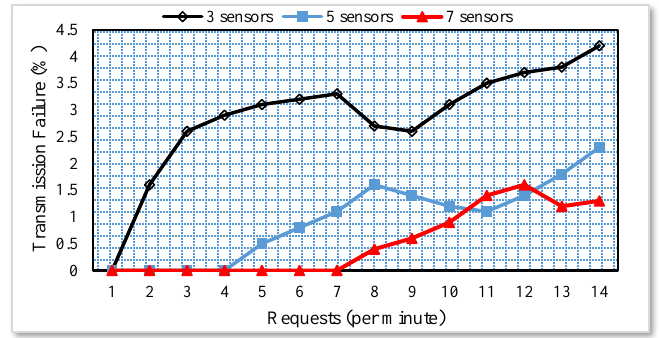
Figure 4. Transmission failure analysis.